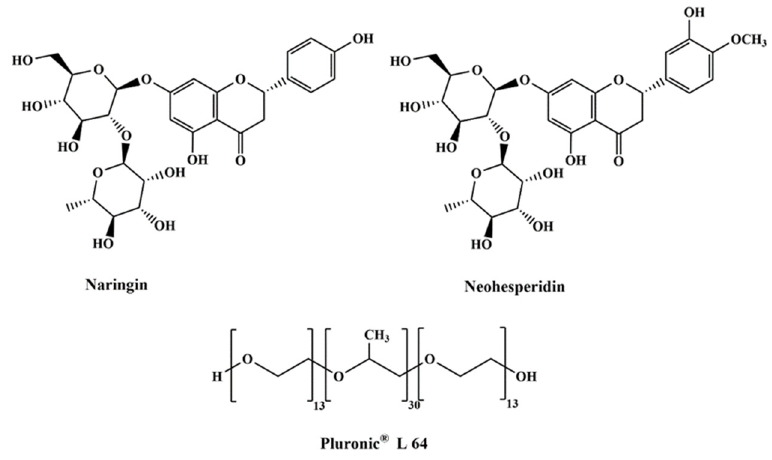
Figure 1. Chemical structures of Nar, Neo, and PL 64.